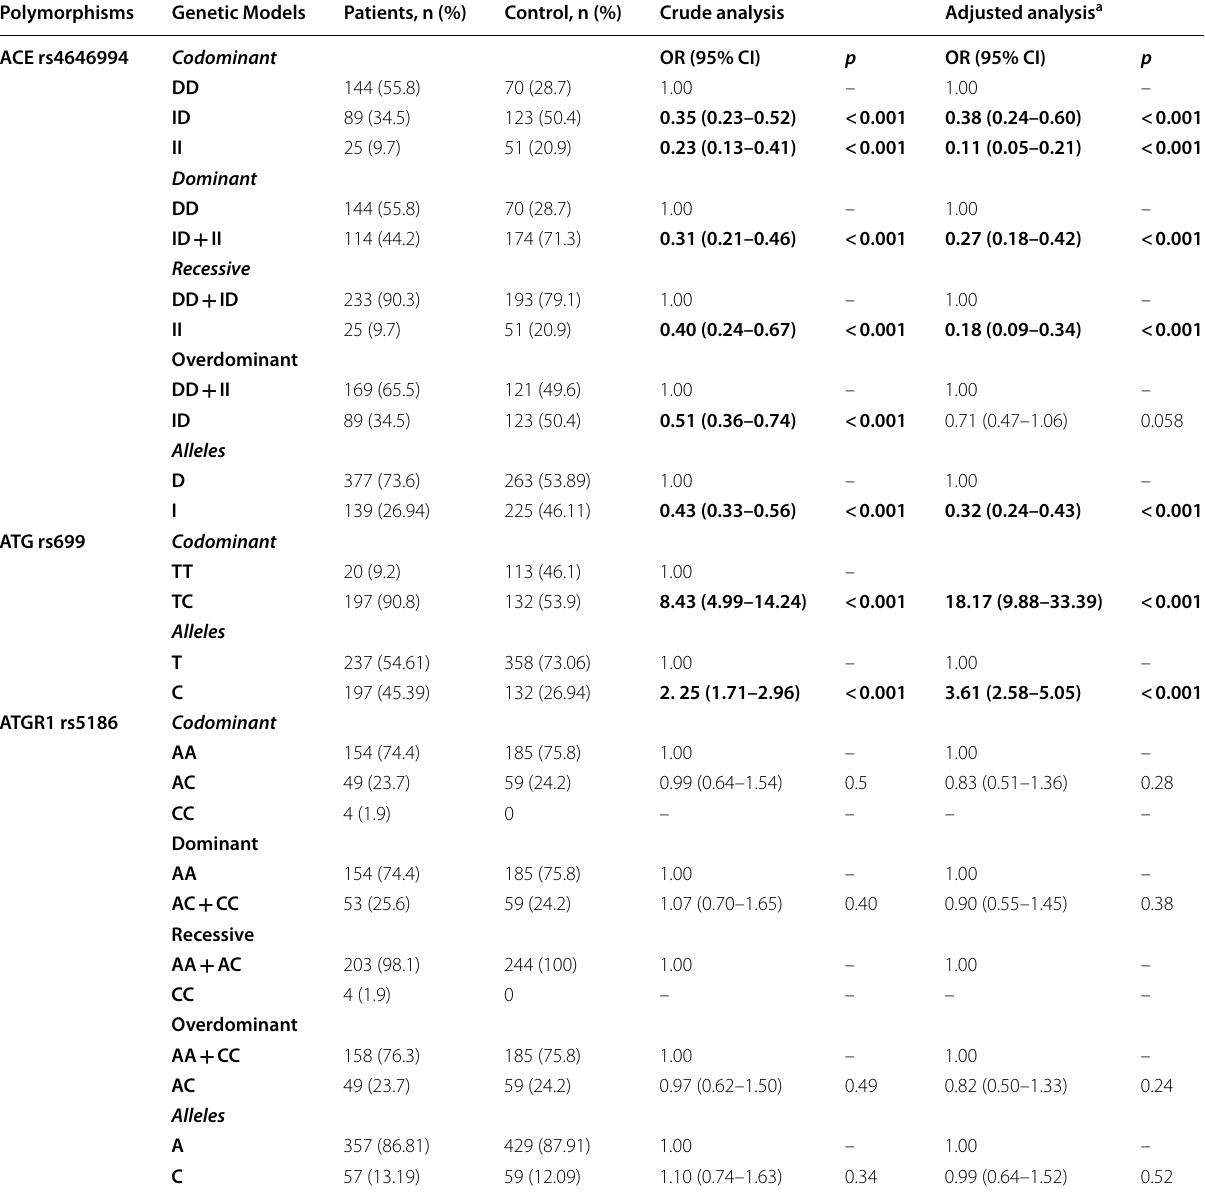
Table 5 Genotypes and allele frequencies of ACE rs4646994, ATG rs699 and AGTR1 rs5186 polymorphisms in COVID-19 patients and